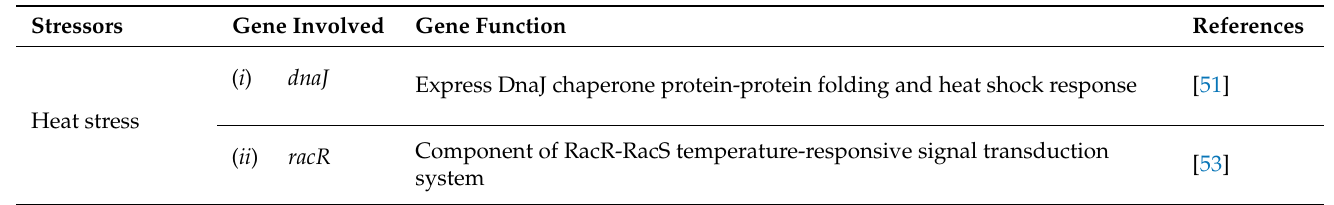
Table 2. Cluster of genes and their potential functions in overcoming multiple stress that C. jejuni encounters in processing